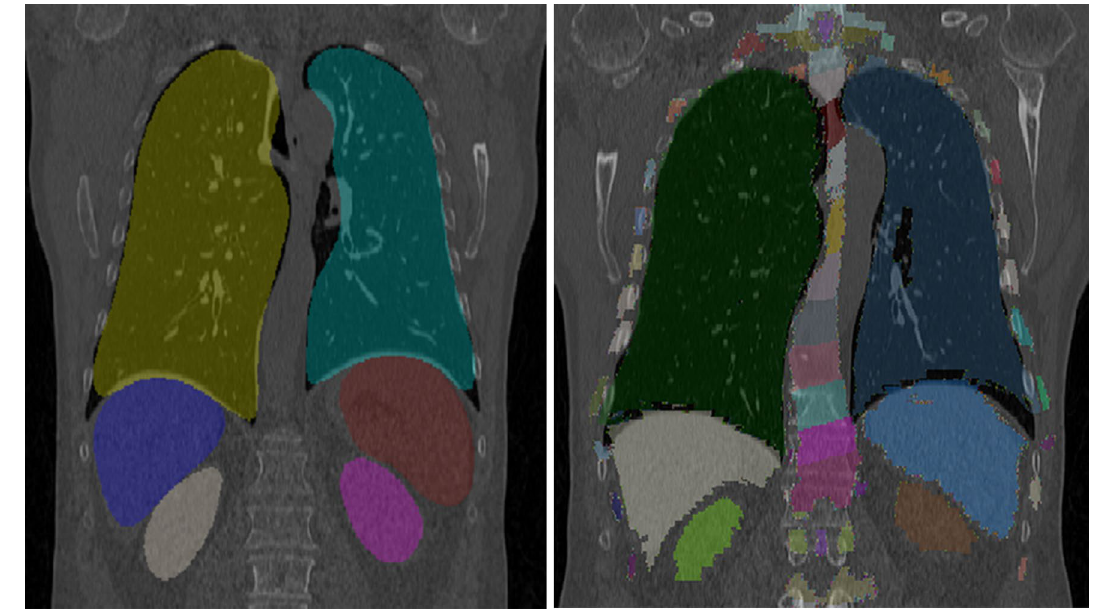
Figure 6. An example of multi-organ segmentation of a CT dataset (left) and warped Visible Human Phantom segmentation overlay